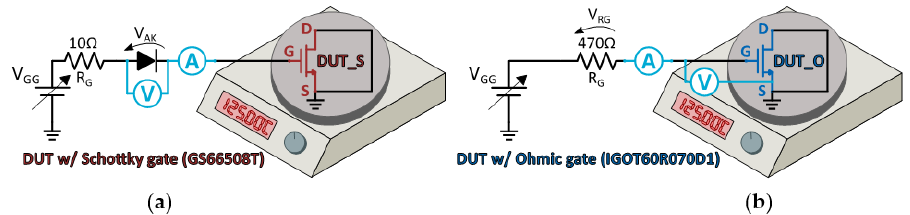
Figure 4. Schematic of the test setup for the static measurement of the gate current as function of the gate-to-source voltage for ( a ) the DUT with Schottky-type gate and ( b ) the DUT with Ohmic-type gate.